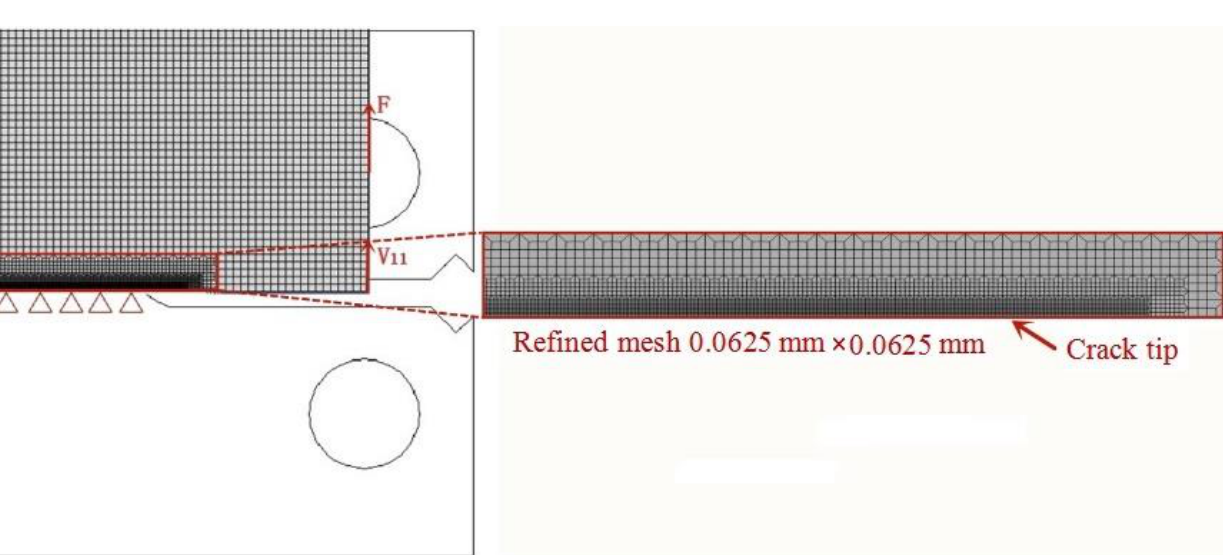
Figure 6. Load-line displacement curves for uncharged and hydrogen-charged CT specimens. Figures 7–9 illustrates the distributions of hydrostatic stress and hydrogen concen- tration along the fracture path at various load steps to determine hydrogen concentration